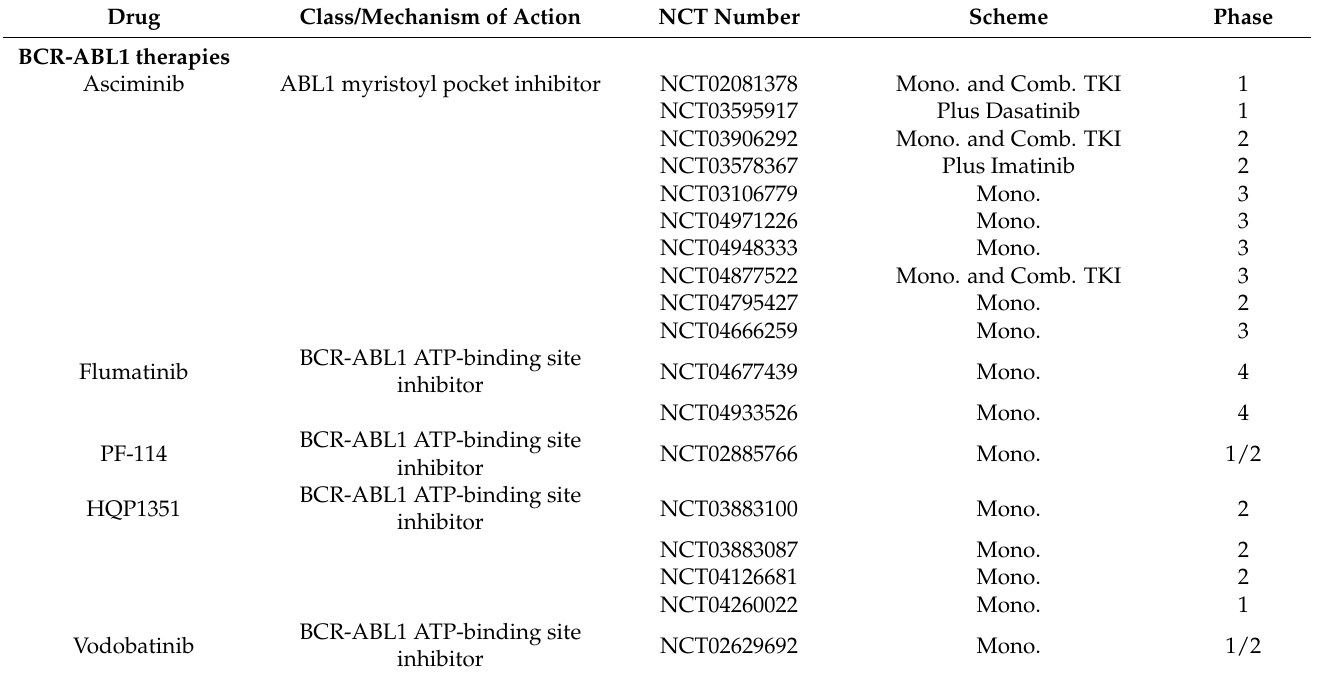
Table 2. Selected clinical trials of different therapeutic strategies in